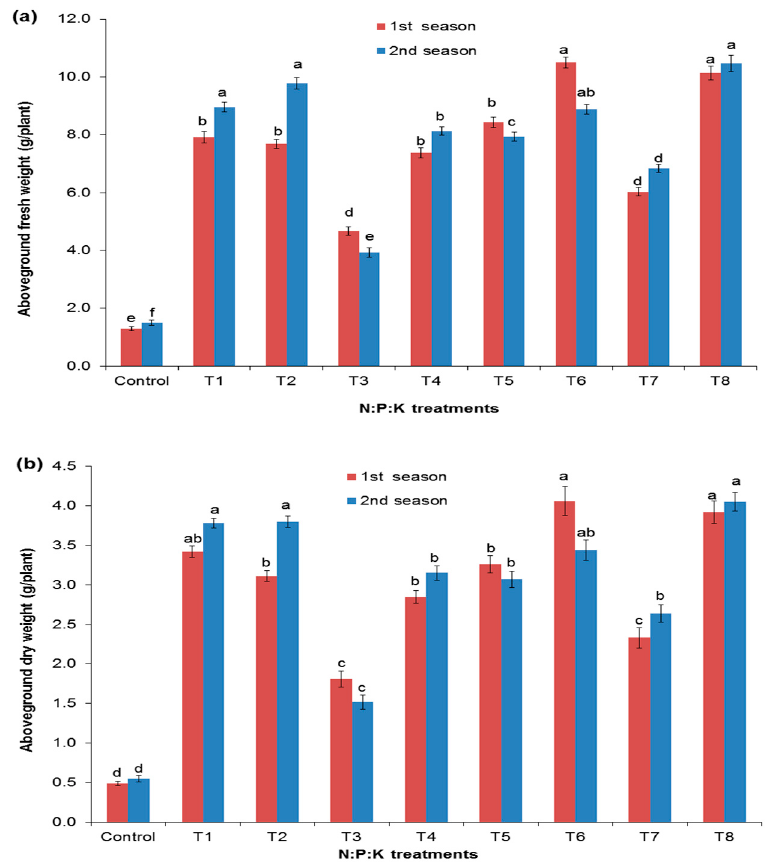
Figure 2. Effect of NPK treatments on the fresh ( a ) and dry weight ( b ) of the aboveground parts of Salvadora persica . Dissimilar letters designate the significance among means ( p < 0.05) using Duncan’s multiple range test (means ± standard errors ( n = 5)) for the different fertilization treatments.